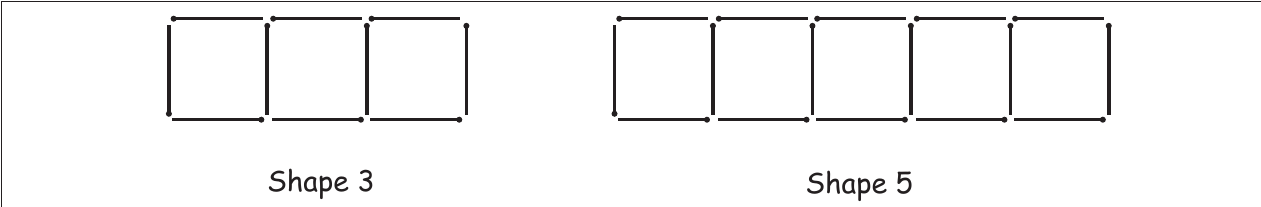
FIGURE 3: Term 3 and Term 5 of a typical pictorial sequence.